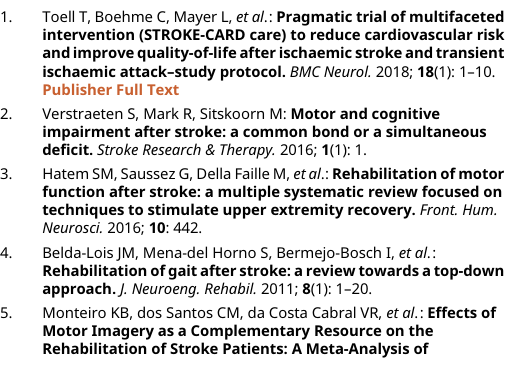
Figshare: Underlying additional data. https://doi.org/10.6084/m9.figshare.19625271.v4. 13